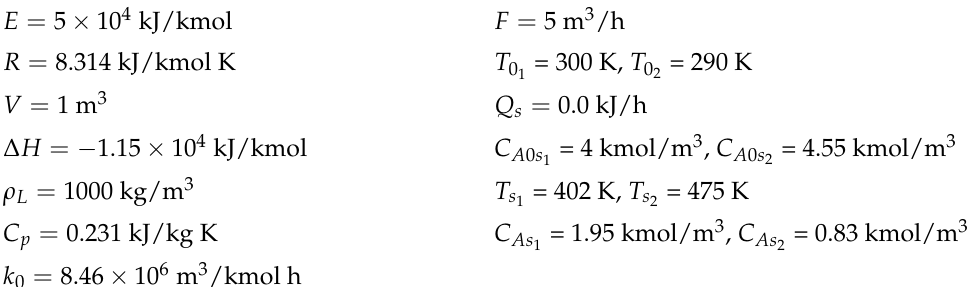
Table 1. Parameter values of the